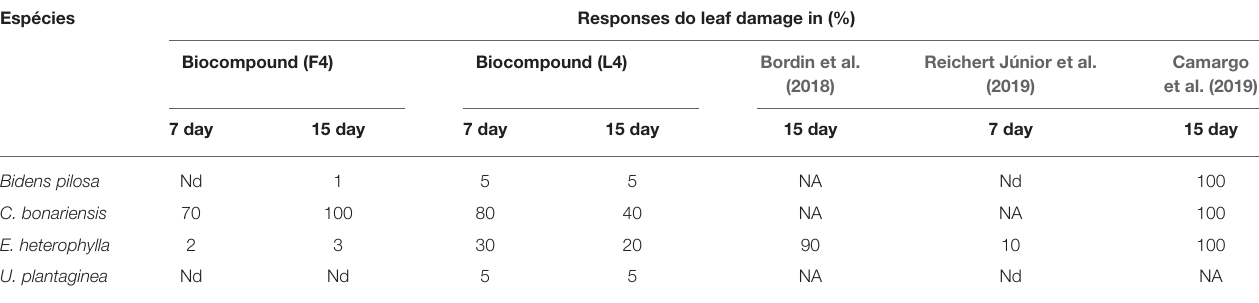
TABLE 3 | Phytotoxicity analysis on weeds after the 7th and 15th day of application of biocompounds F4 and L4 and comparison with studies carried out by Bordin et al. (2018) , Reichert Júnior et al. (2019), and Camargo et al. (2019).